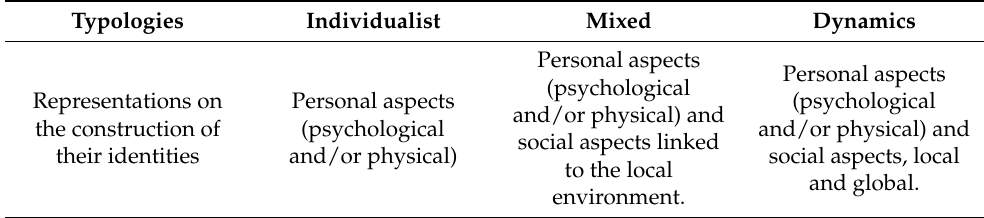
Table 5. Perspectives on the construction of their